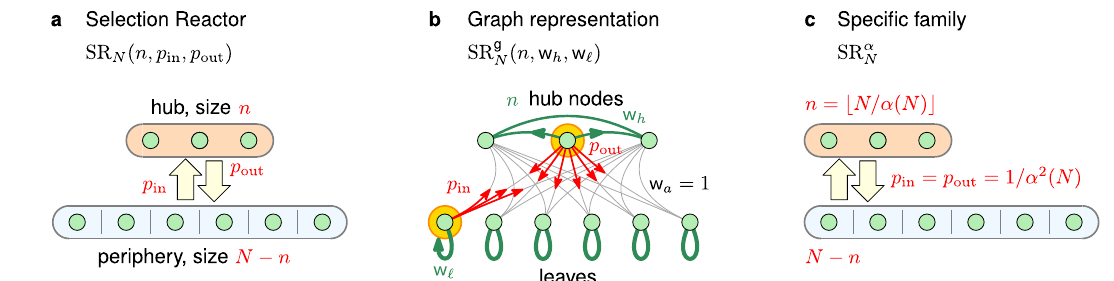
Fig. 3 Selection reactors. a A selection reactor SR N ( n , p in , p out ) consists of two compartments: A central well-mixed `hub' (orange) containing n nodes and the remaining N − n isolated ‘ leaves' in the periphery. An offspring of a reproducing individual migrates to the other compartment with probability p in , resp. g p n ; w ; w n , the weight w w h of all edges within the hub, and the weight ℓ h ‘ Þ is parametrized by the hub size N ð out . b As a weighted graph, selection reactor SR of all self-loops on the leaves. The migration rates p in and p out then satisfy p in = n /( n + w ℓ ) and p out = ( N − n )/(( N − n ) + ( n − 1) w h ). c Given a slowly growing unbounded function α ( N ), a selection reactor SR α N has n = ⌊ N / α ( N ) ⌋ nodes in the hub and the migration rates satisfy p in = p out = 1/ α 2 ( N ) (here N = 9, α (9) = 3, and ⌊⌋ denotes the fl oor